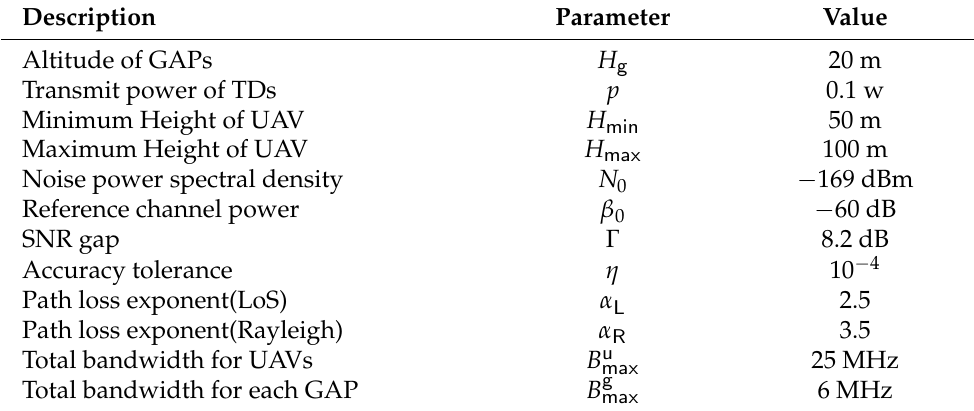
Table 1. Parameter setting in